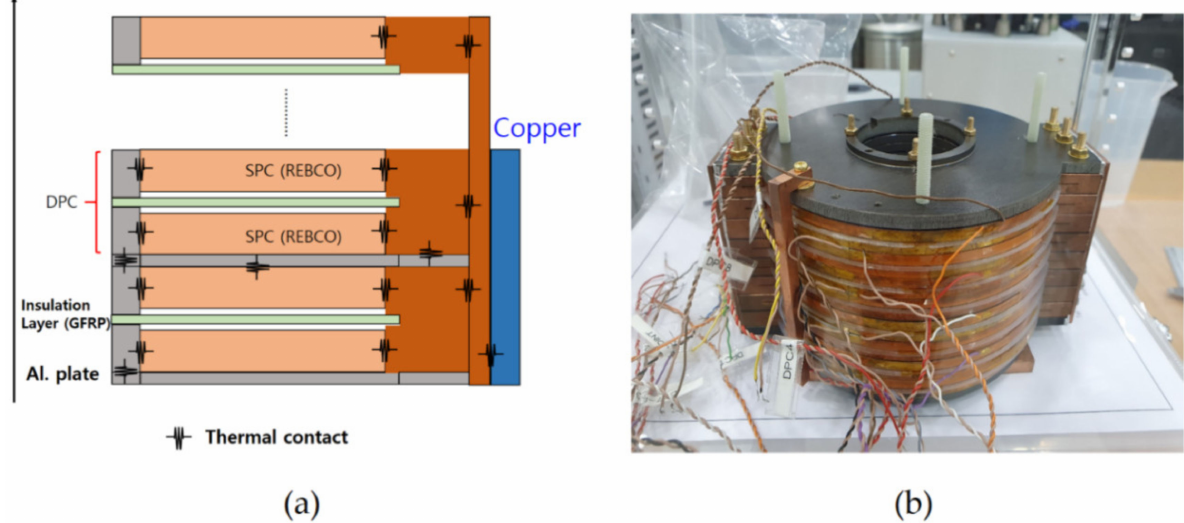
Figure 7. ( a ) The cross-sectional structure, and ( b ) front view of the 3 T REBCO